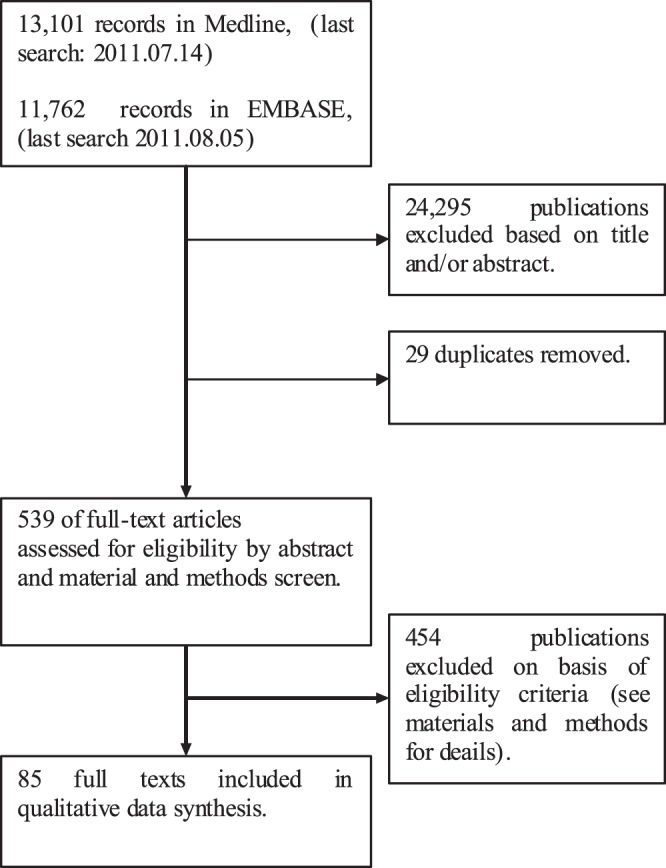
PRISMA flow diagram.